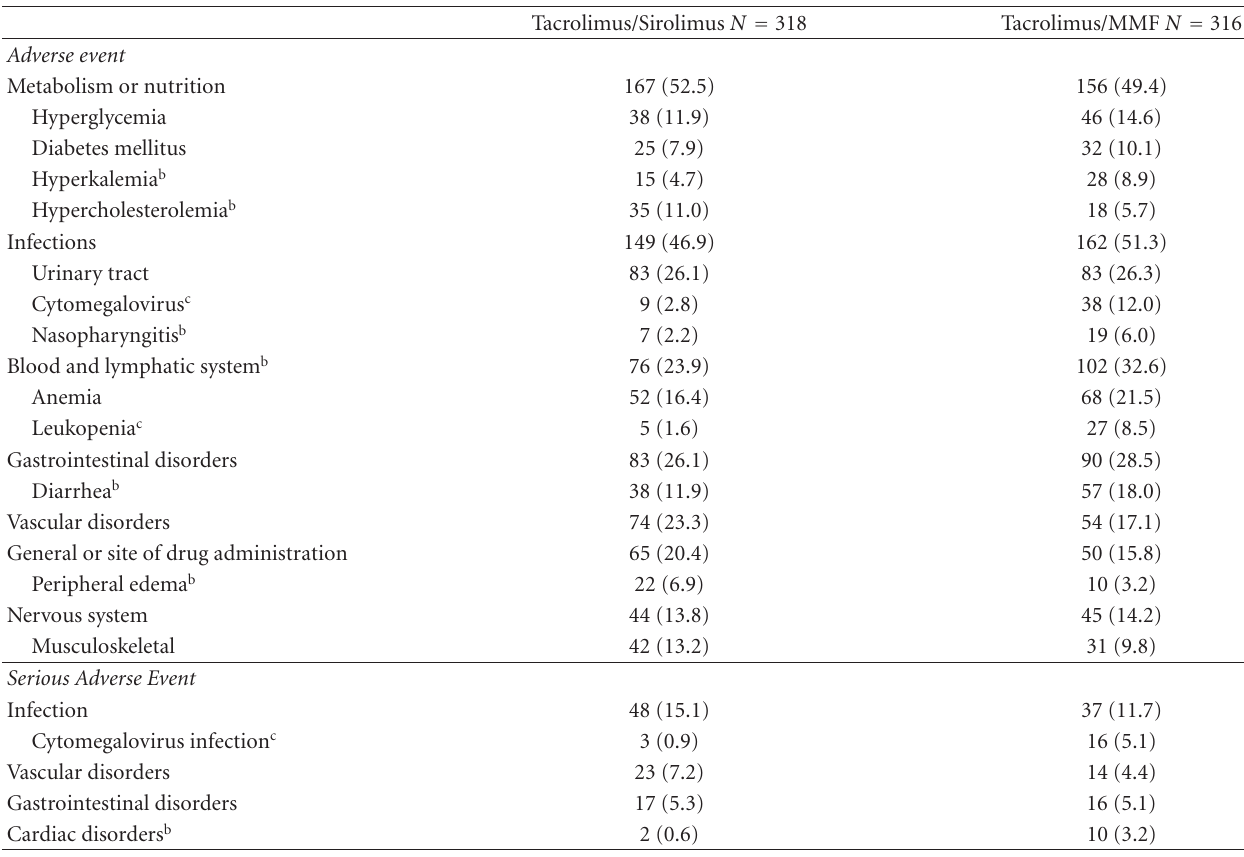
Table 4: Commonly reported a adverse events—number (%) of patients.